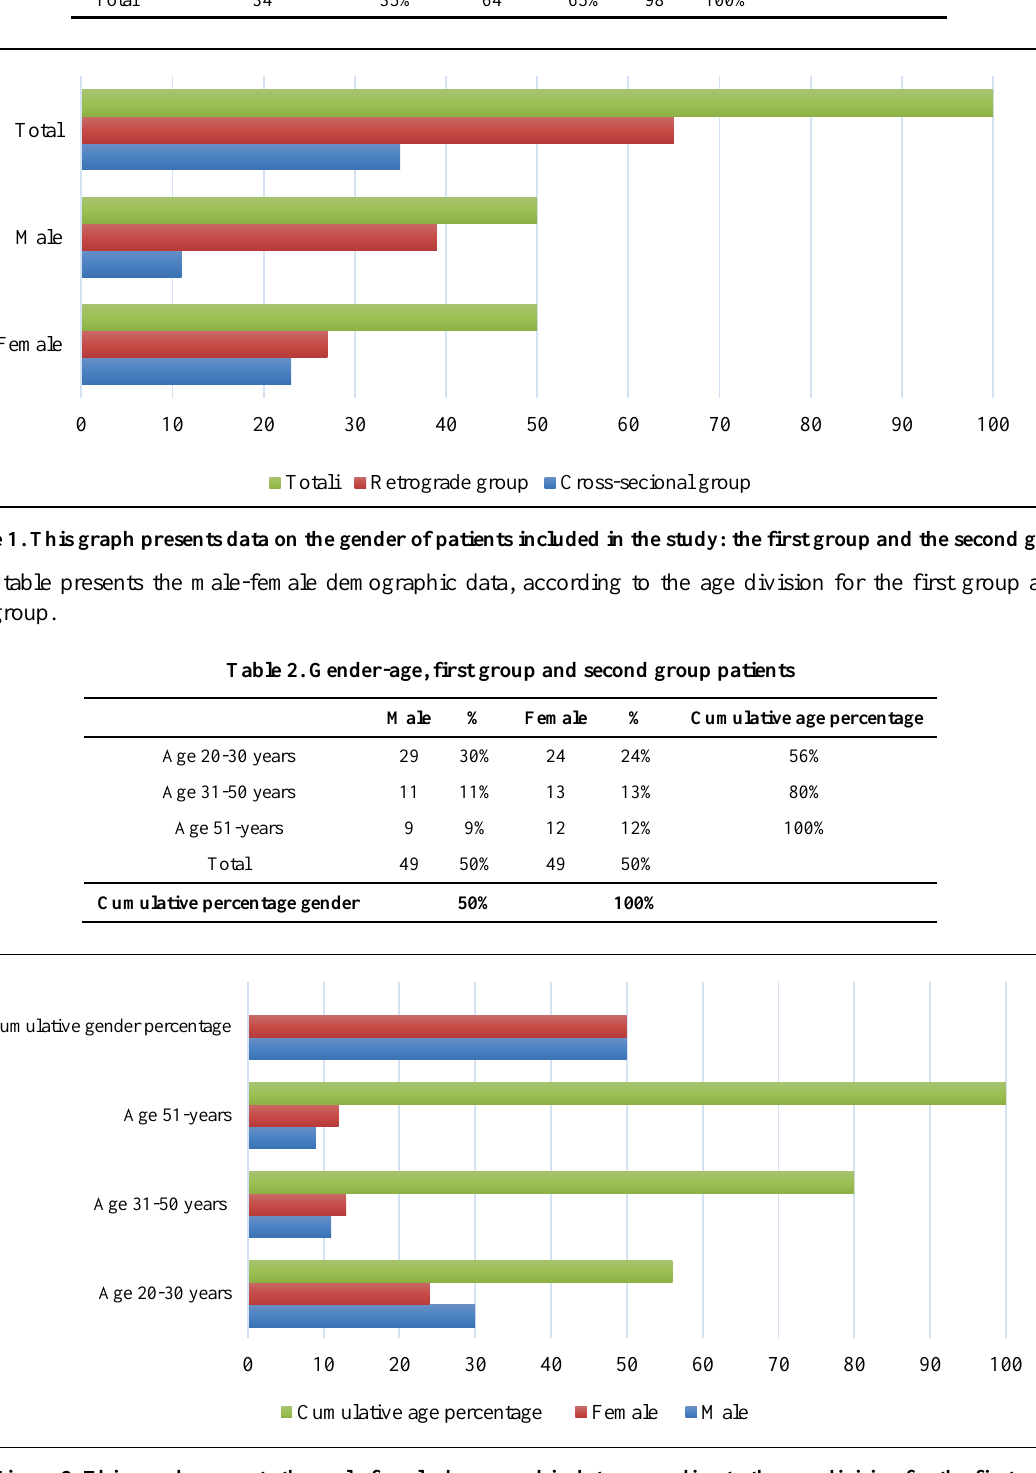
Figure 2. This graph presents the male-female demographic data, according to the age division for the first group and the second group Table 3 shows the recorded data on dental health status, for the group of patients on cross-sectional and retrograde